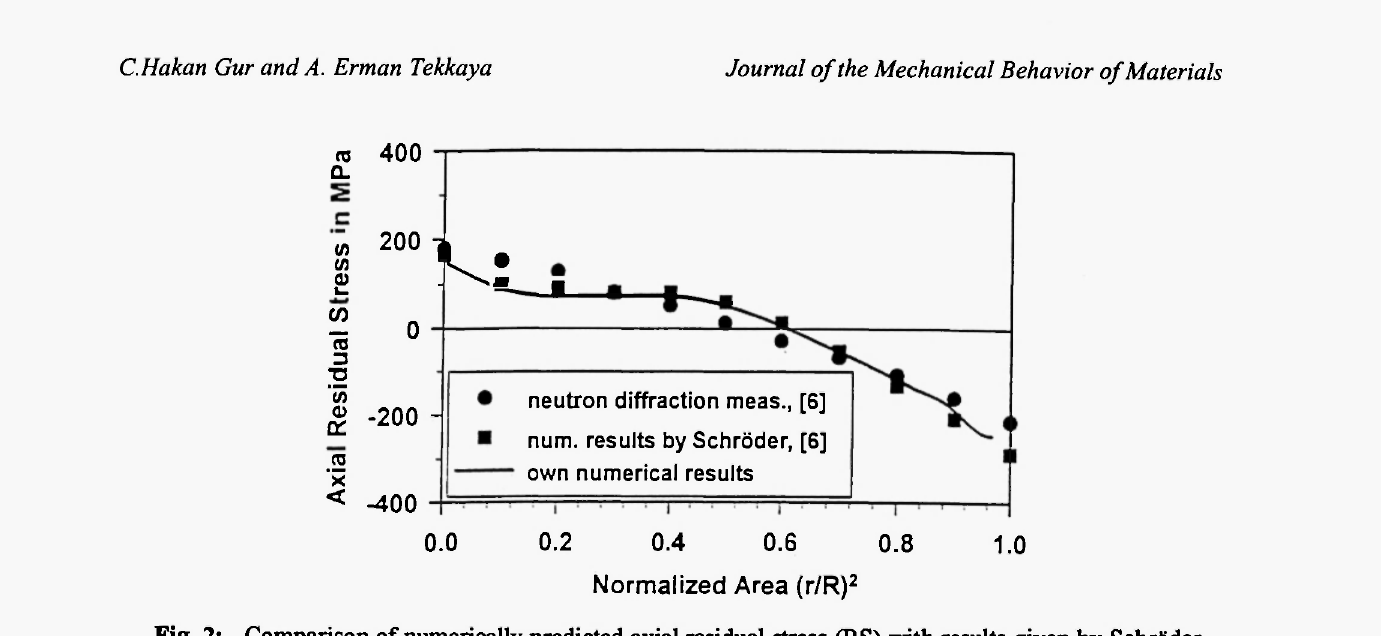
Fig. 2: Comparison of numerically predicted axial residual stress (RS) with results given by Schröder 161.